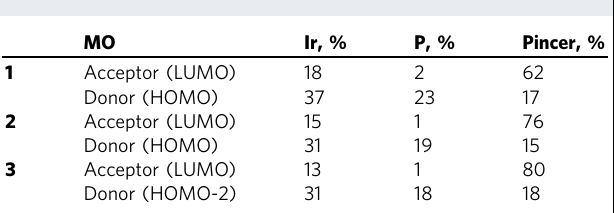
Fig. 6 Photophysical studies of 1 – 3 in solution state. UV-vis absorption (thin line) and emission (thick line) spectra of complexes 1 – 3 in CH 3 CN solution at 298 K. Excitation at λ ex = 470 nm. Inset shows the photographs of 1 in degassed CH 3 CN solution under ambient light and UV light.